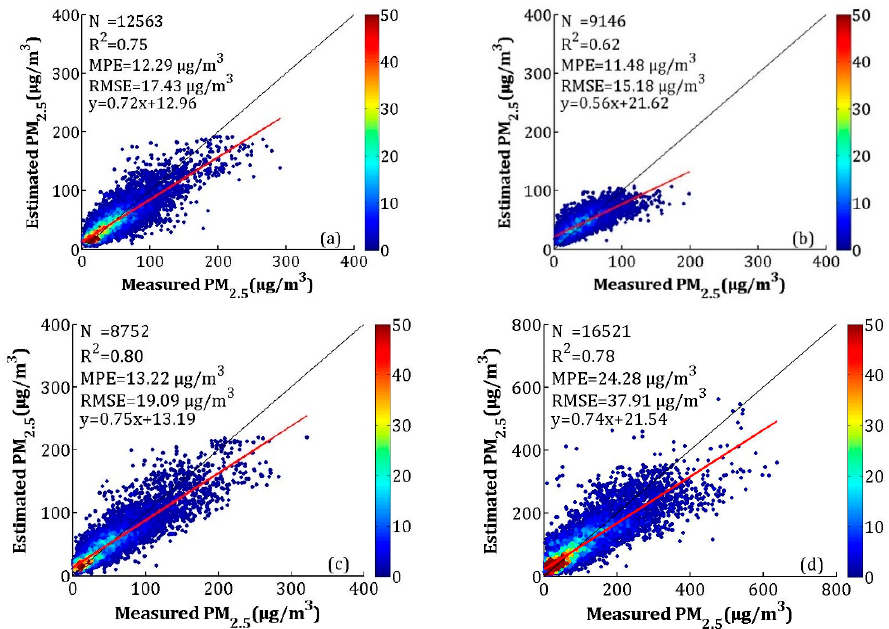
Figure 11. Assessment of seasonal LME model performance based on measured and estimated PM 2.5 concentrations for cross-validation ( a ) spring, ( b ) summer, ( c ) autumn, ( d ) winter.